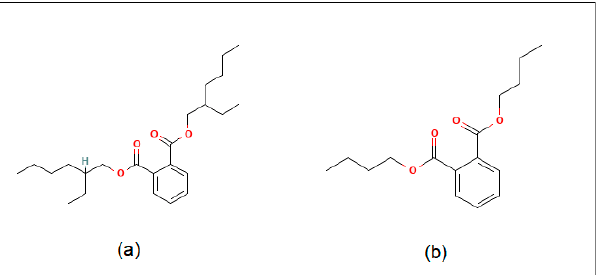
Figure 1. Structures of ( a ) Di-2-ethylhexyl phthalate identified in the HEX fractions (DBCHI-1 (F1 to 5), DBCHI-3 (F9 to 14) and DBCHI-4 (F15)) and ACE fractions ((DBCHII-6 (F16-17-18) and DBCHII-11 (F18)); ( b ) Dibutyl phthalate identified in ACE fractions DBCHII-34 (F61 to F65).